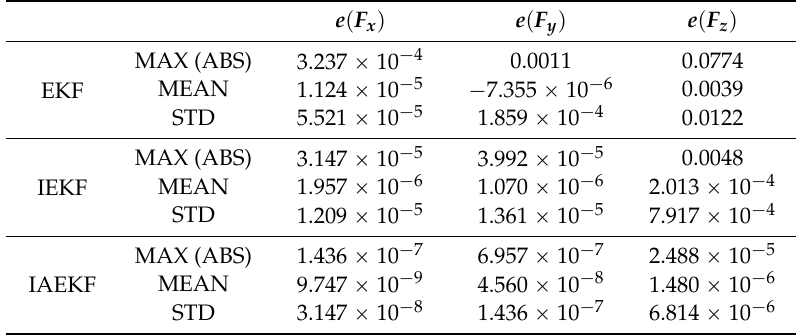
Figure 4. Contact force estimation (CFE) error by EKF-based algorithms with the applied force in all directions including sudden changes. Table 3. Comparison of EKF-based estimators for the applied spatial forces (N).